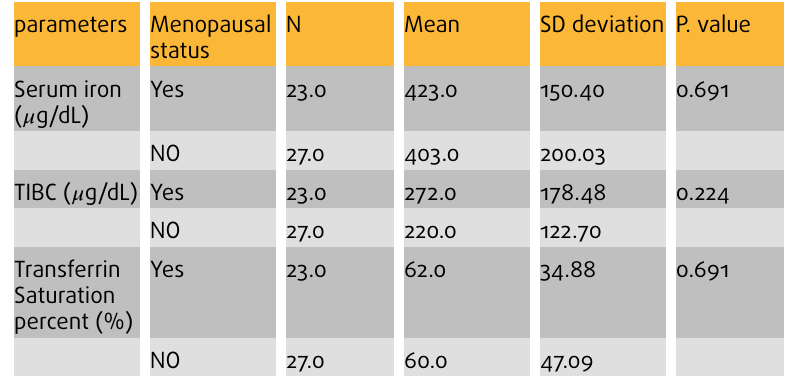
Bloom Richardson’s grading